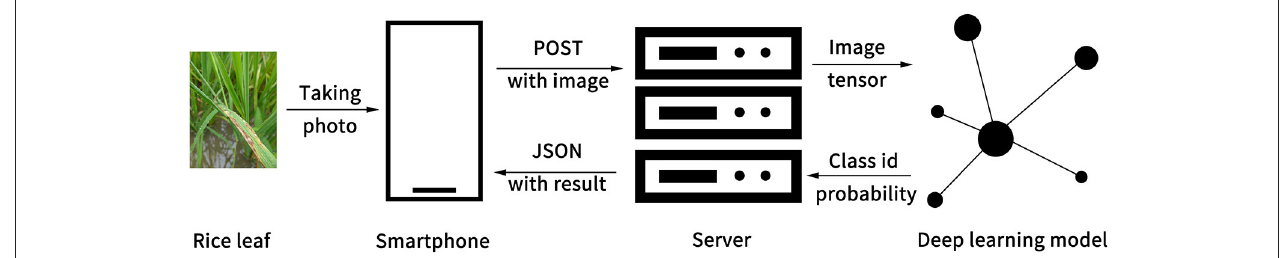
FIGURE 4 | Software architecture of the system.